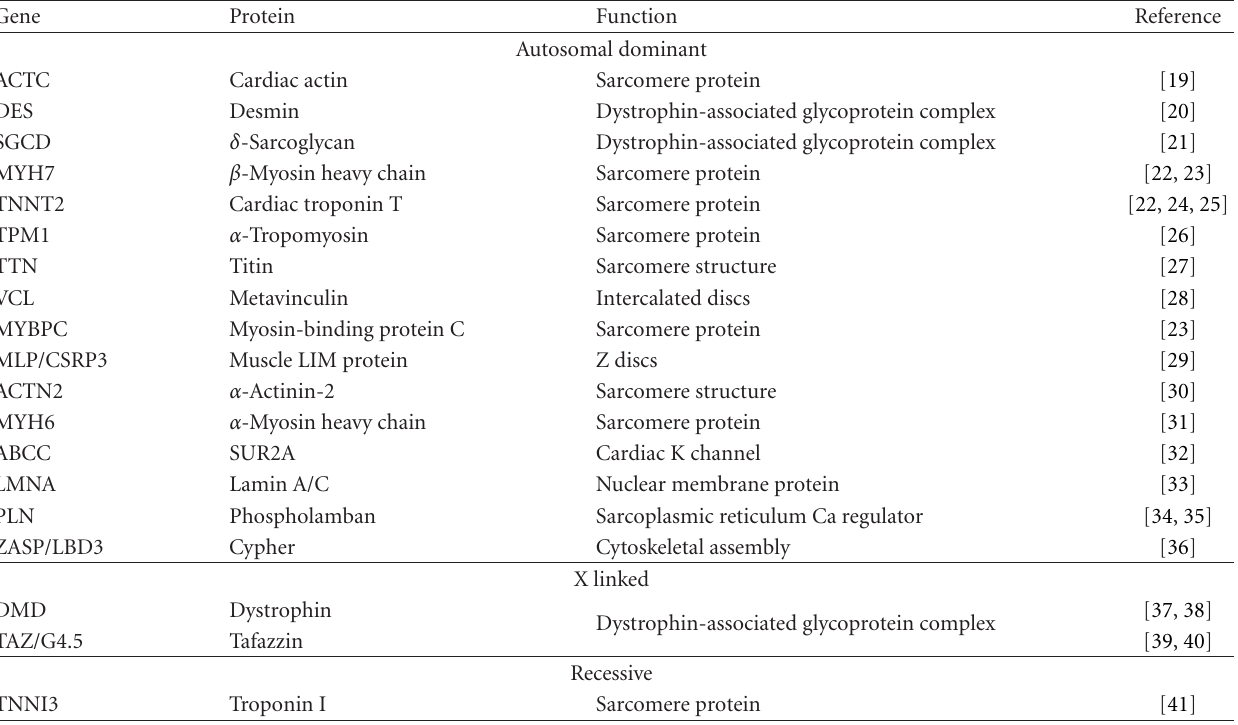
Table 3: Genes associated with dilated